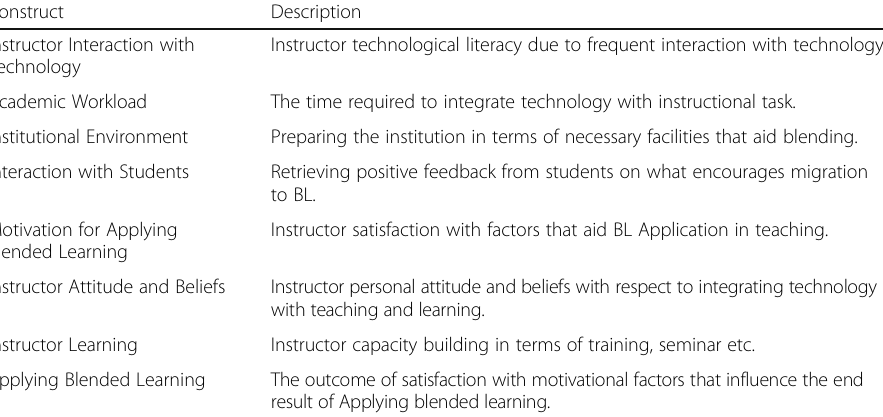
Table 1 Research Model Constructs Summary